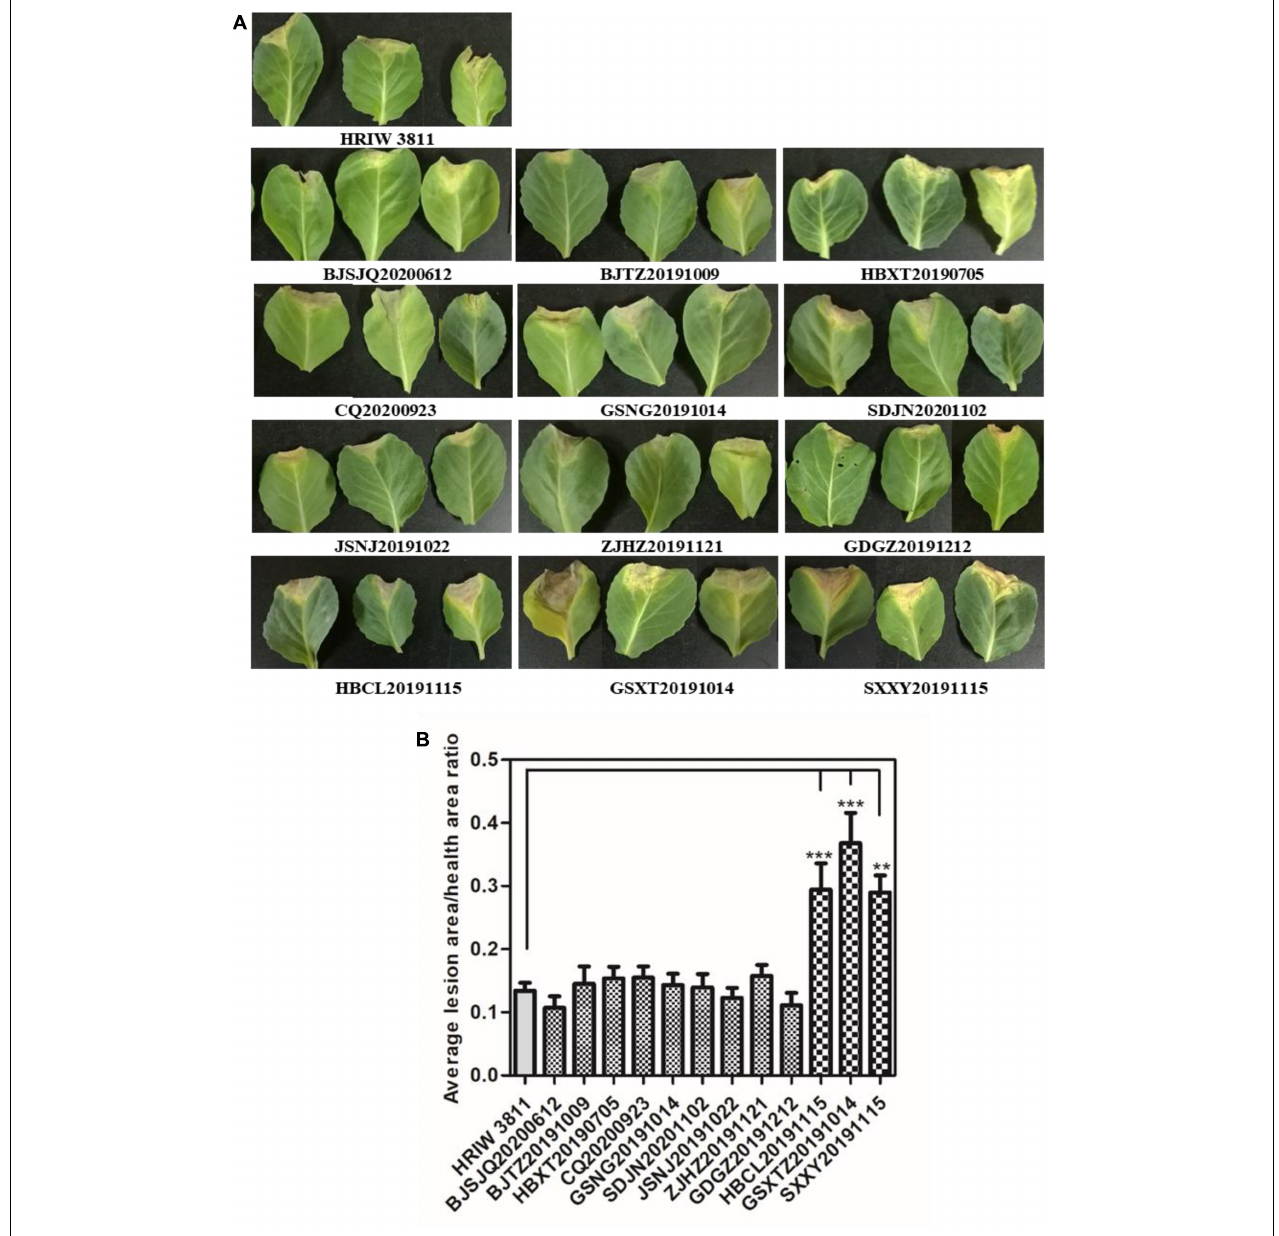
FIGURE 2 | Pathogenicity analysis of isolated strains on cabbage. (A) All 12 isolated Xcc strains caused typical V-shaped lesions in the cabbage after leaf clipping inoculation. The average lesion area/health area ratio (per leaf) caused by three isolated strains (HBCL20191115, SXXY20191115, and GSXT20191014) were larger than that caused by the positive control (HRIW 3811 strain). Photos were taken at 7 d post-inoculation. (B) The average lesion area/health area ratio triggered by the isolated strains were bigger than that caused by HRIW 3811. Lesion and health area were measured using 20 leaves samples at 10 d post-inoculation (data are means ± SD; n > 3; ** P < 0.01 and *** P <